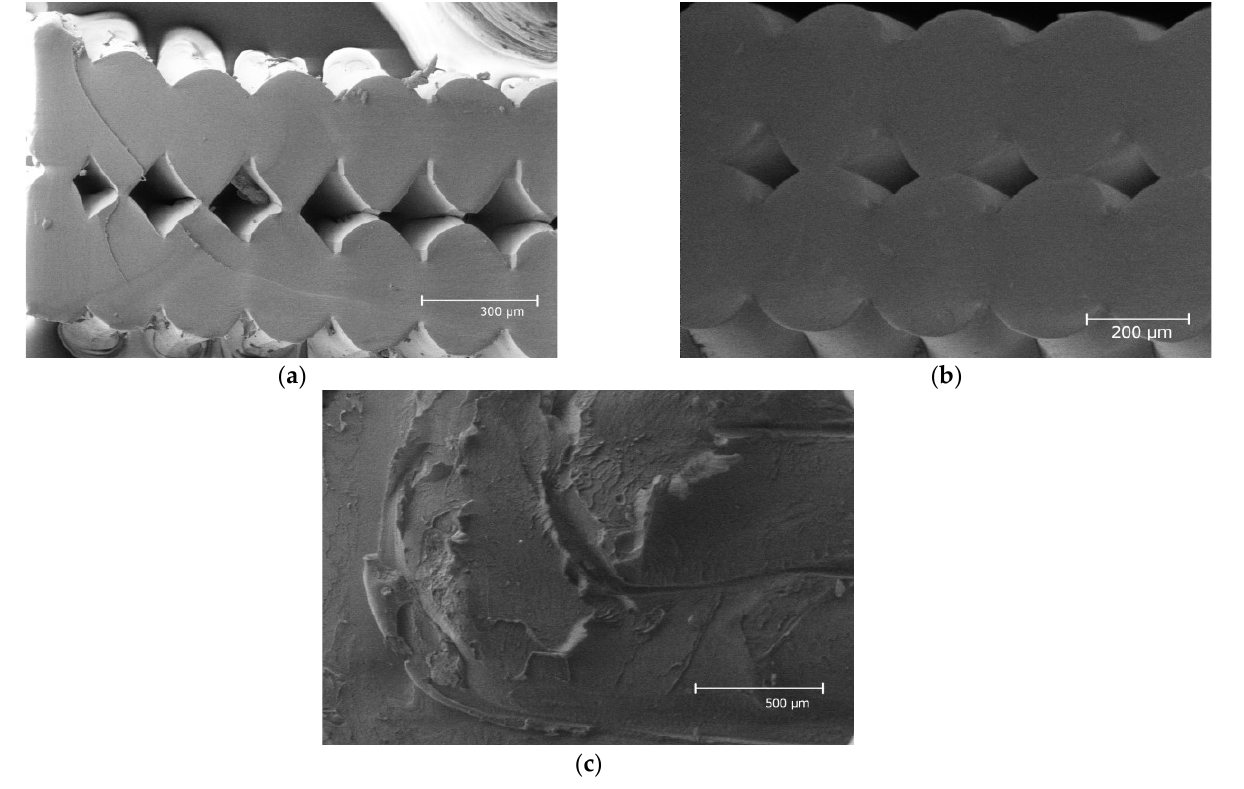
Figure 4. Transverse cross-sections of Ultem samples after cooling at RT printed in X ( a ), Y ( b ), and Z ( c ) directions and studied by SEM.